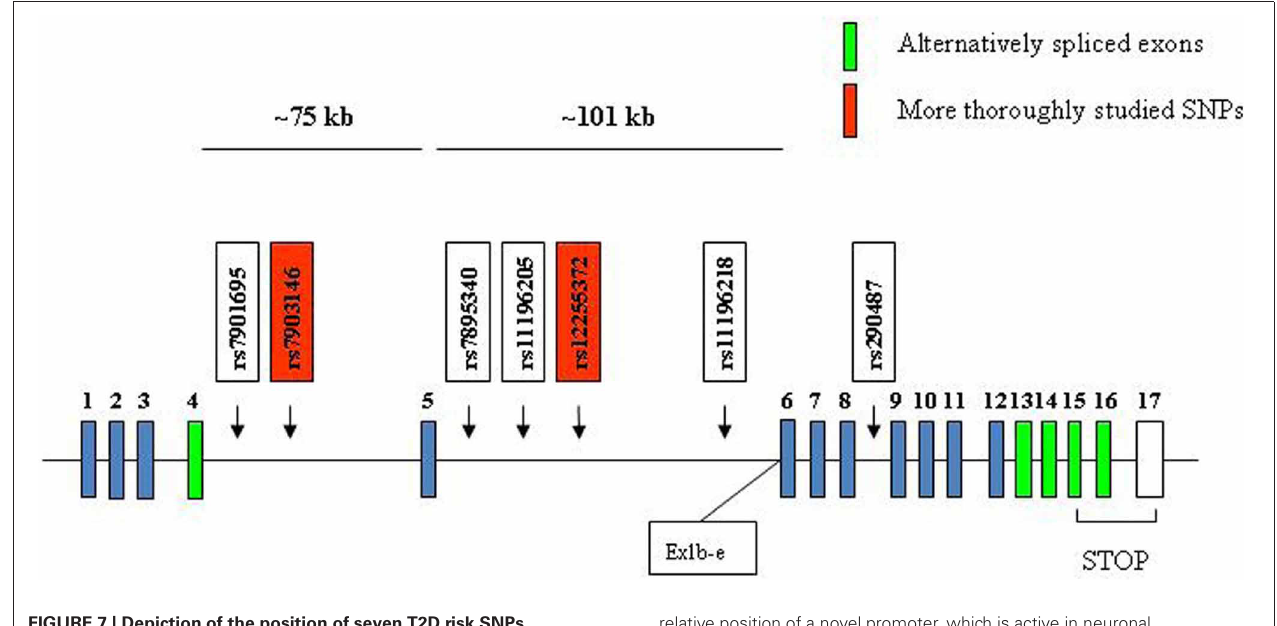
relative position of a novel promoter, which is active in neuronal cells during embryonic stages and leads to the generation of dominant negative TCF7L2, lacking the first 161 amino acid residues at the N